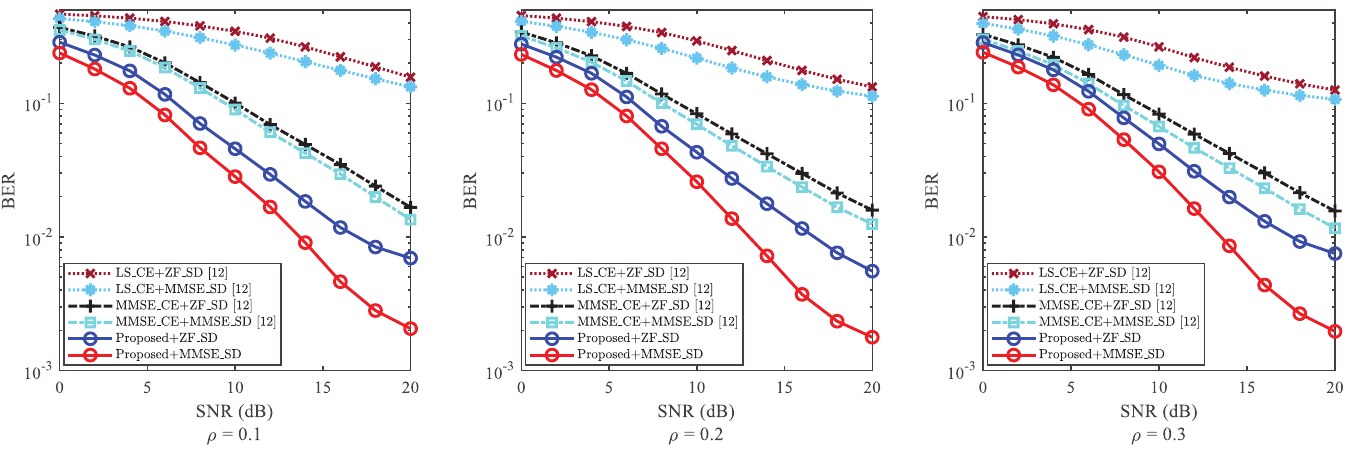
Fig 8. BER of SD against the impact of ρ , where ρ = 0.1, ρ = 0.2 and ρ = 0.3 are considered, respectively.